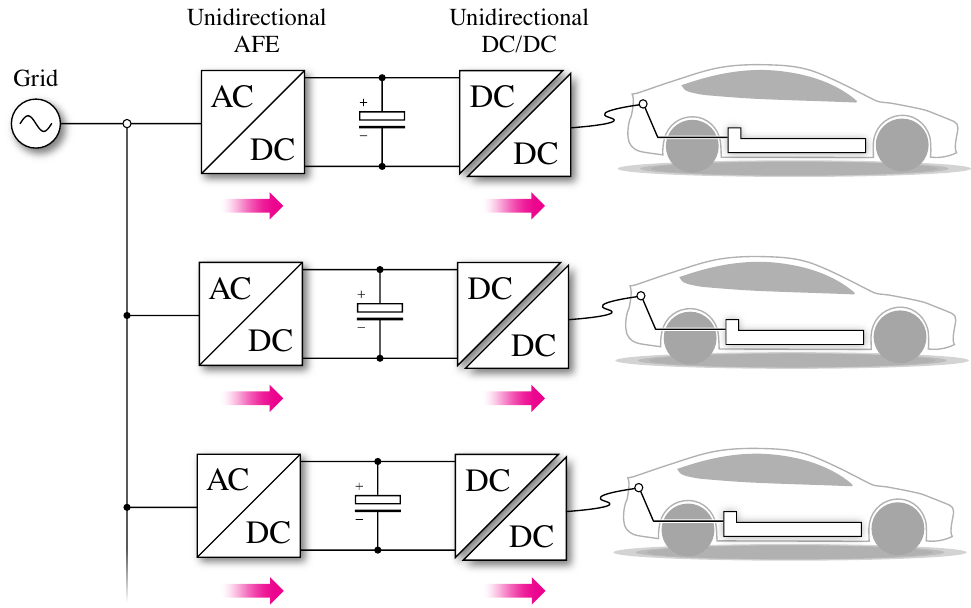
Figure 4. Simplified schematic of a conventional unidirectional EV fast-charging station without energy